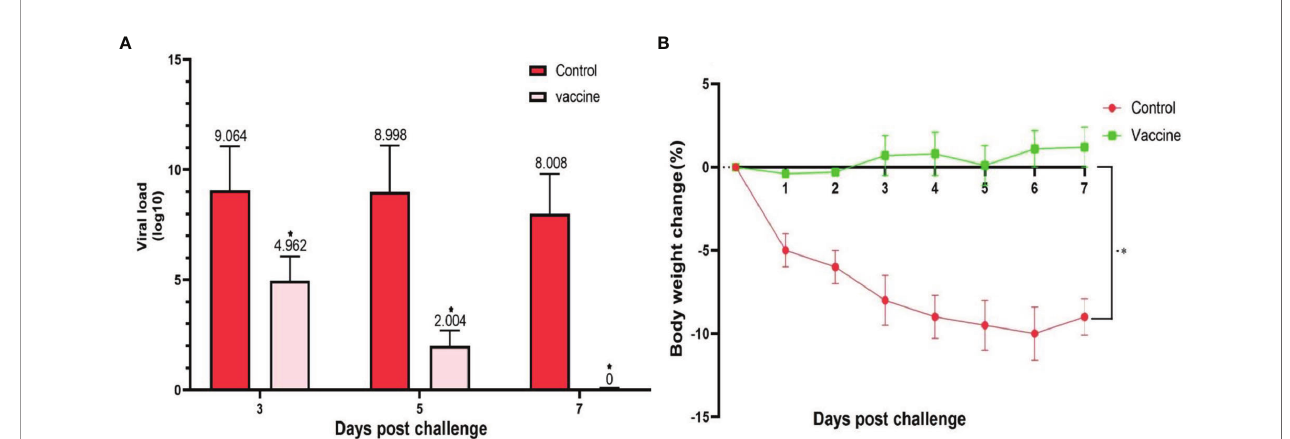
FIGURE 9 | SARS-CoV-2 challenge of immunized hamsters (103 ± 20g) with middle (M) dose of candidate vaccine. (A) The viral load was calculated as TCID50%/mL. Lungs samples of the control group showed an average titer of 1.16×10 9 TCID50/ml, 7.83×10 8 TCID50/ml, and 10.2×10 7 TCID50/ml on 3, 5 and 7 DPI, respectively. In the vaccinated groups with the middle dose of candidate vaccines, the lung viral titer was remarkably low compared to the control group as 9.17×10 4 TCID50/ml, 10.2×10 3 , and 0 on 3, 5, and 7 DPI, respectively. However, the vaccinated group did not show any live virus titer in any of the specimens on 5 and 7 DPI. (B) The weight change between day 0 and day 7 post SARS-CoV-2 challenge of the vaccinated and control hamsters. There was a signi fi cant difference in weight between the RAZI-COV PARS vaccine and the control group during the period of observation on days 1 and 2 (P <0.05) as well as statistically very signi fi cantly on days 3 to 7 (P <0.01). Results are presented as the mean ± SD. Comparisons between control and vaccine group were made between the two groups by T-test (P < 0.05). p values lower that 0.05 were considered to be statistically signi fi cant (*p